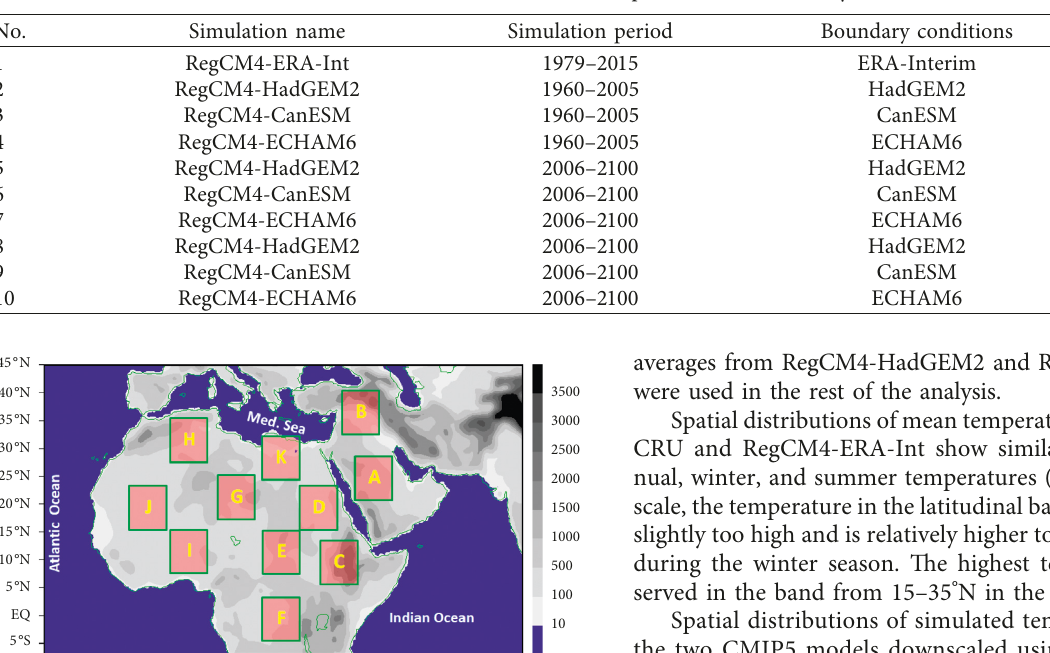
Table 1: List of simulations performed in this study.